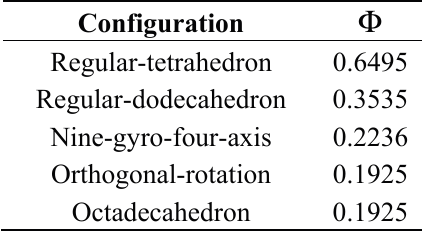
Table 1. The value Φ of different redundant